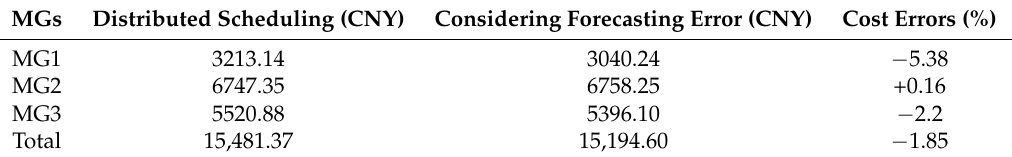
Table 5. Operation cost of the MGs considering the forecasting